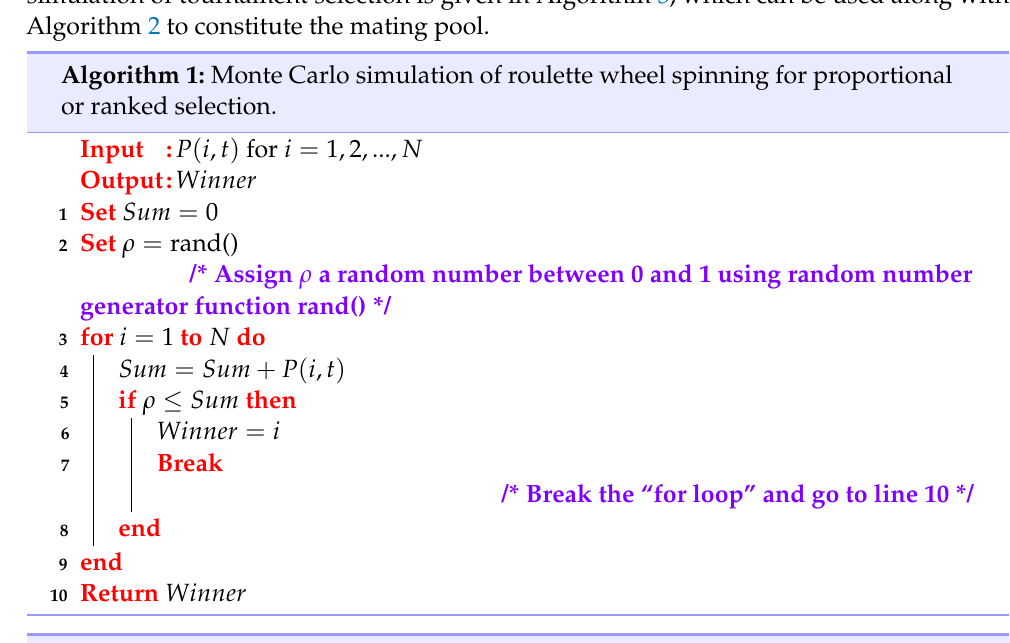
Algorithm 2: Creating the mating pool M ( t ) .